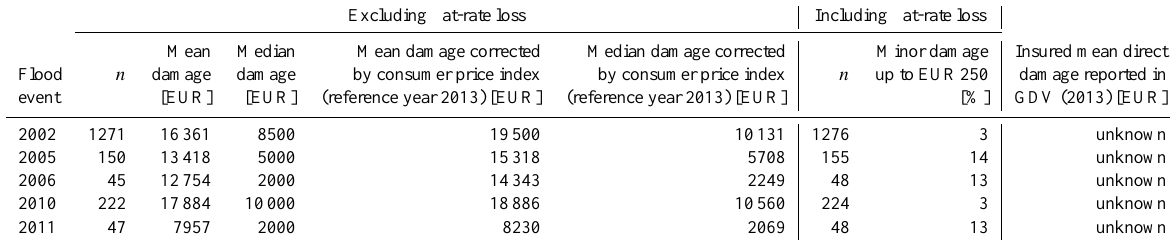
Table 10. Flood damage of household contents.